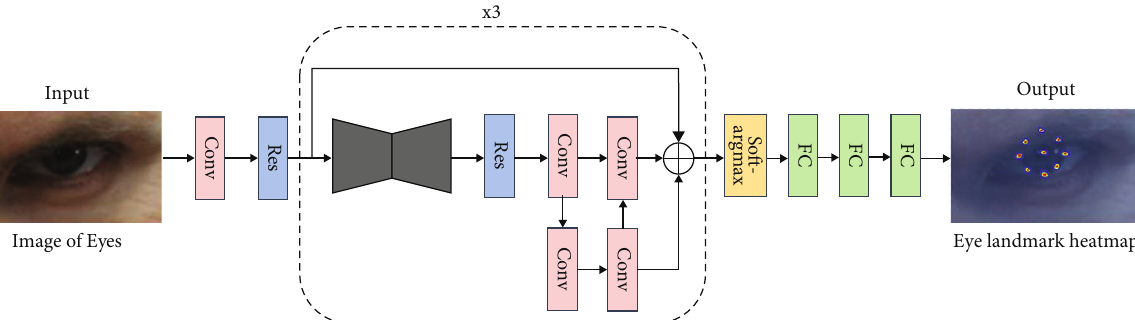
Figure 2: The whole network architecture.